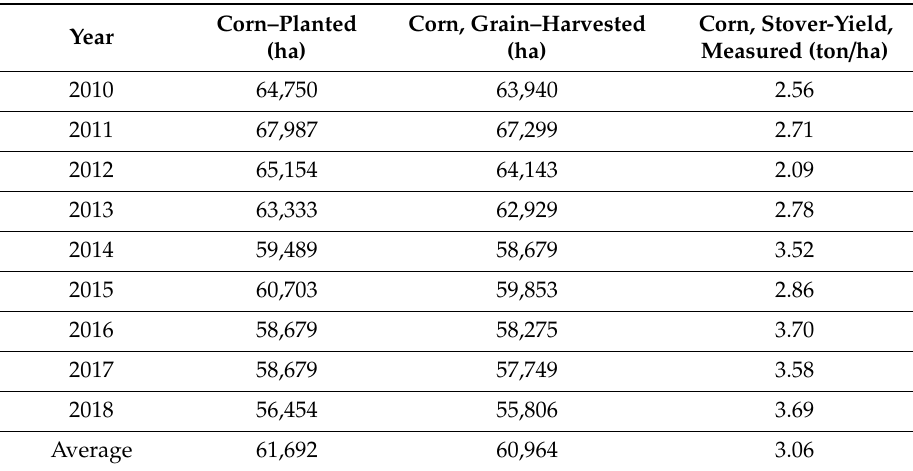
Table 3. Corn yield data in Tazewell County, Illinois, U.S.